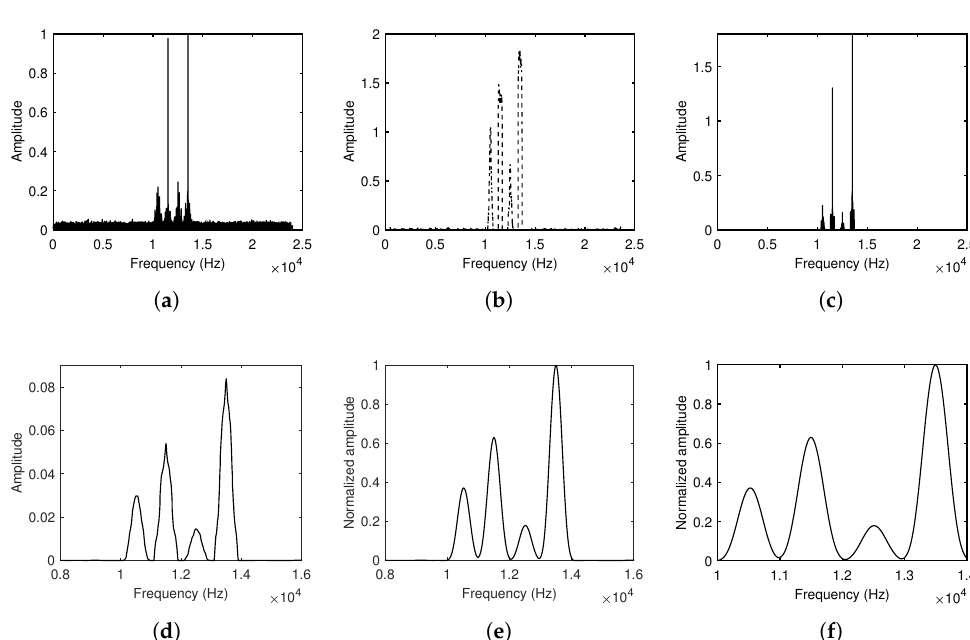
Figure 5. Waveform optimization of 4FSK. ( a ) Waveform after absolute value acquisition, ( b ) gain coefficient, ( c ) waveform after spectral peak enhancement, ( d ) partial enlargement of the waveform after moving average filtering, ( e ) partial enlargement of the waveform after Gaussian fitting, and ( f ) partial enlargement of ( e ).